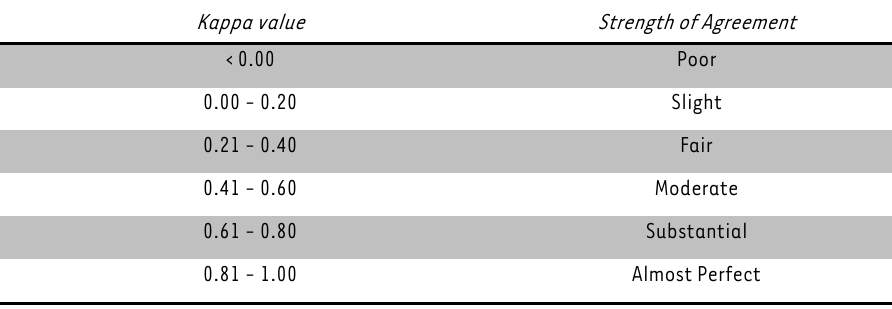
TABLE 9: Interpretation of Cohen’s